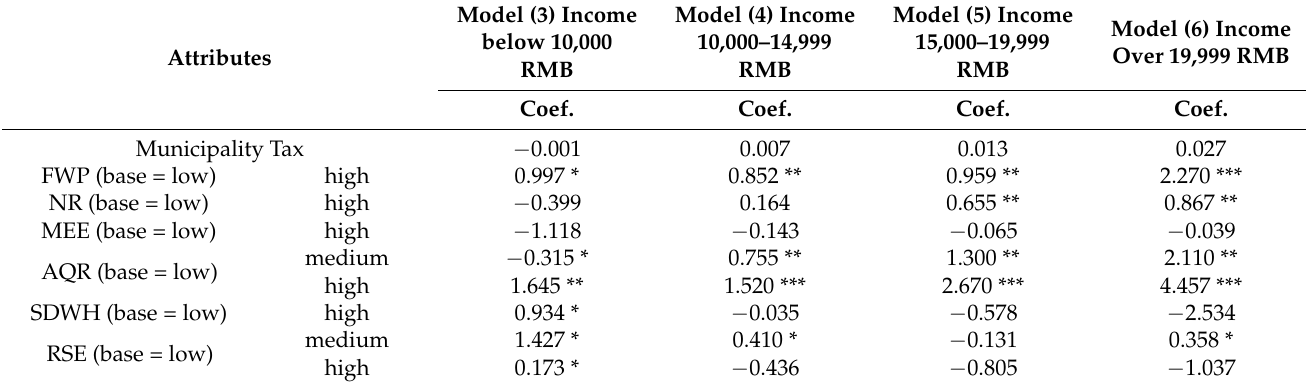
Table 14. Comparison of WTP values for different monthly household income